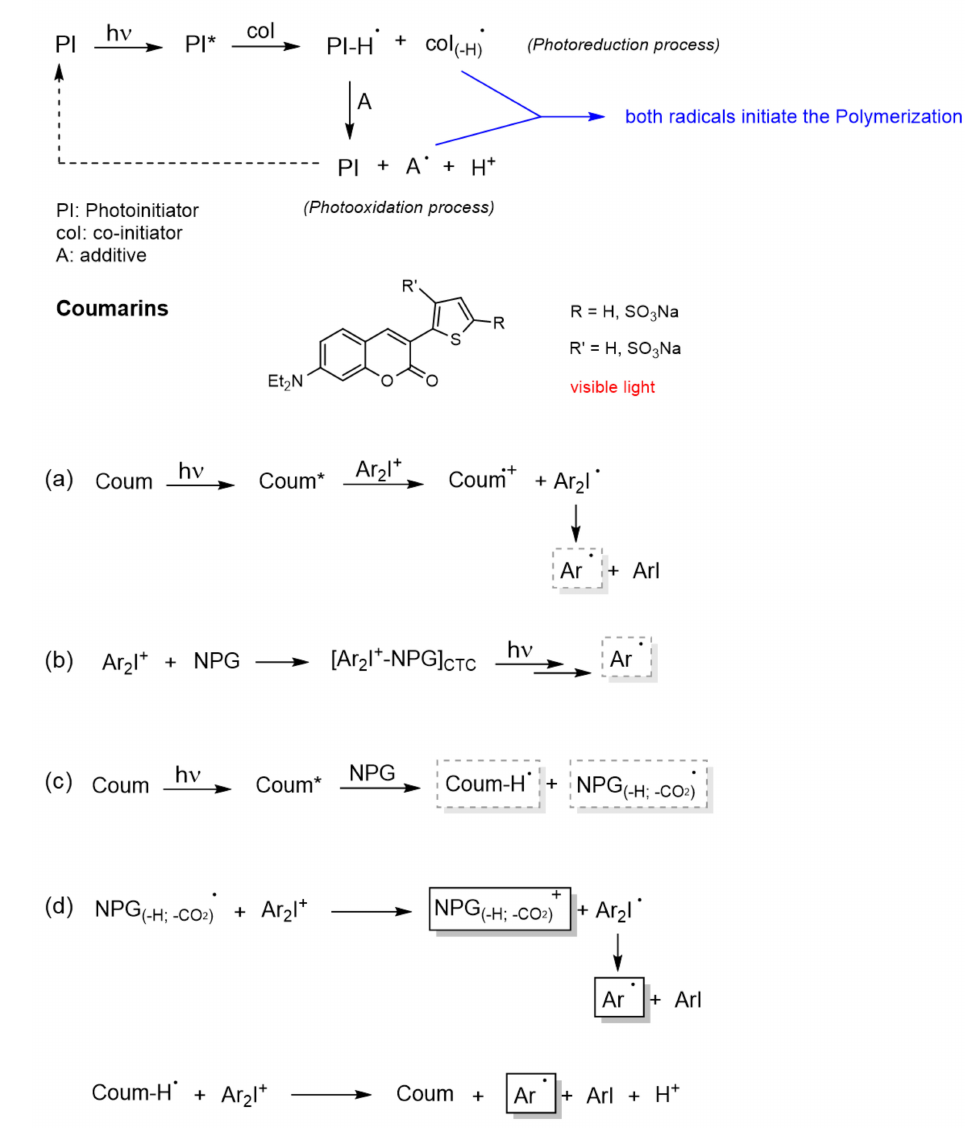
Figure 12. Multicomponent coumarin-based PIs. Mechanistic pathway of the systems: ( a ) Coum/Iod, ( b ) NPG/Iod, ( c ) Coum/NPG, and ( d ) Coum/Iod/NPG. The asterisk (*) denotes the excited state of the